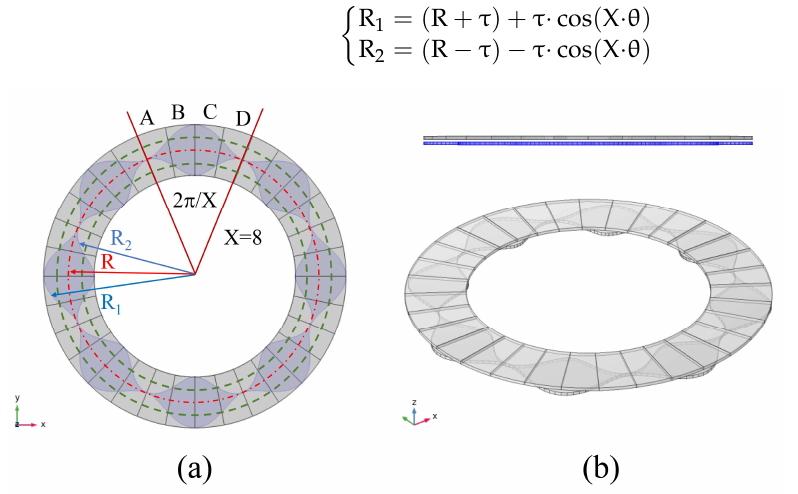
Figure 2. ( a ) Mathematical model schematic and ( b ) side and stereo